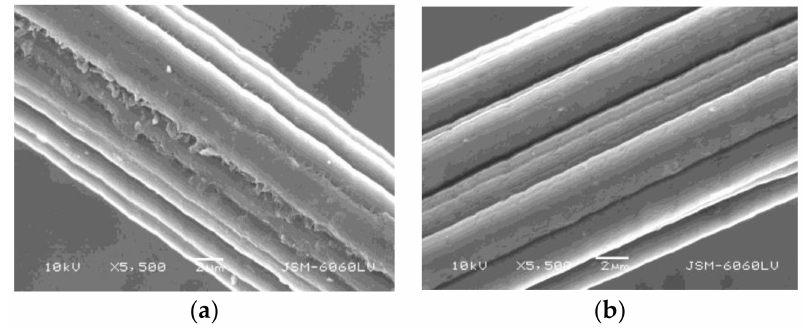
Figure 7. Surface of regenerated cellulose fibers firstly treated with chitosan and then with ( a ) Ultrasound; ( b ) Plasma; all at magnification 5500 × and voltage 10